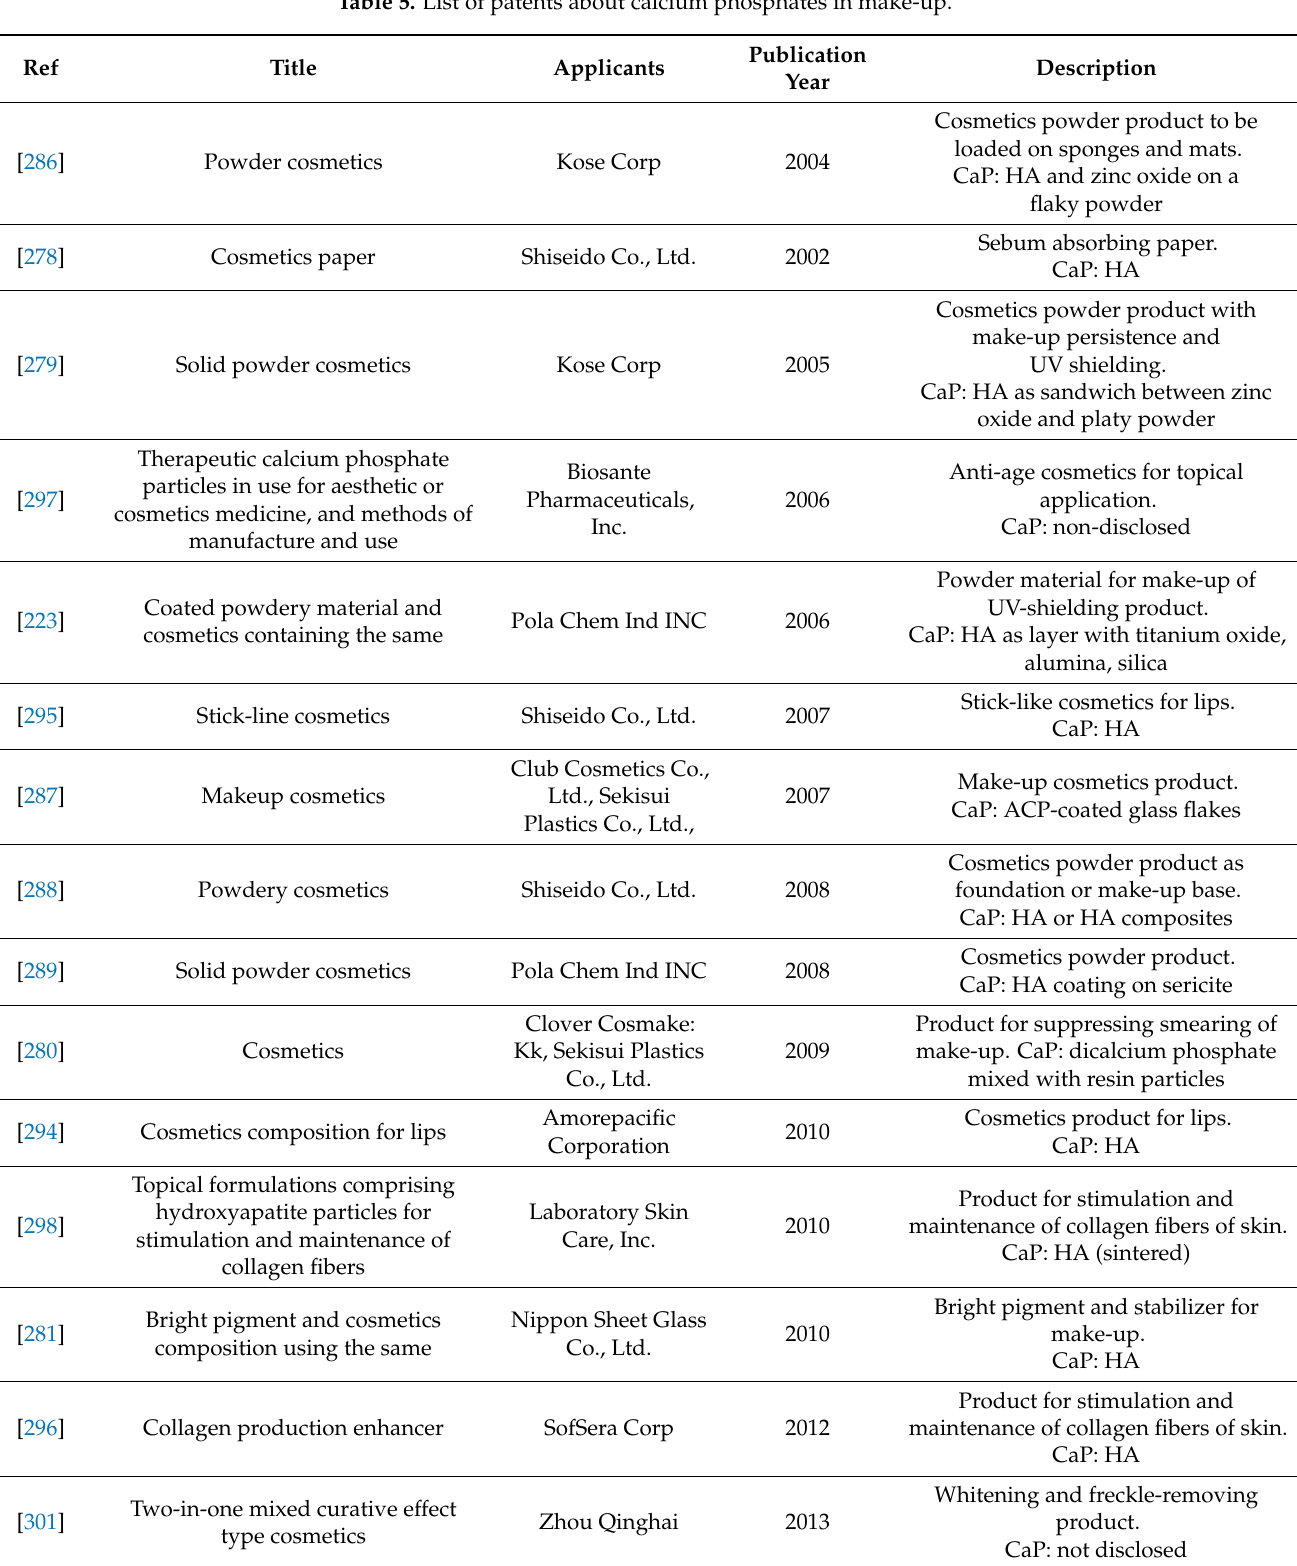
Table 5. List of patents about calcium phosphates in